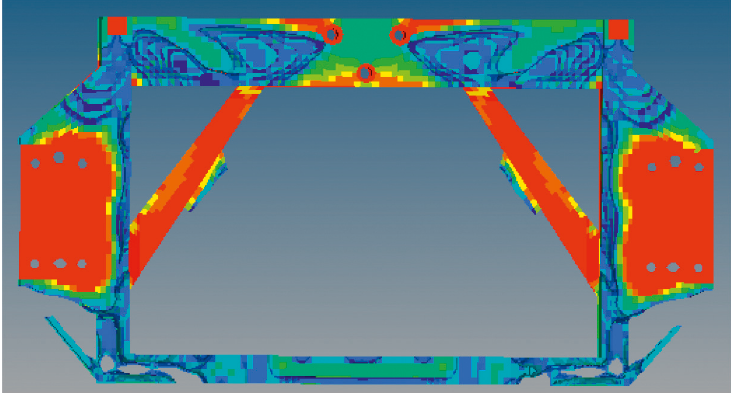
Figure 11: Optimization results based on the compromise planning method.